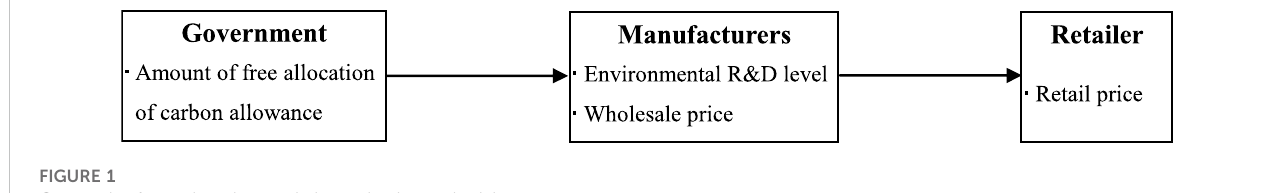
FIGURE 1 Game rules for each carbon emission reduction and pricing strategy.